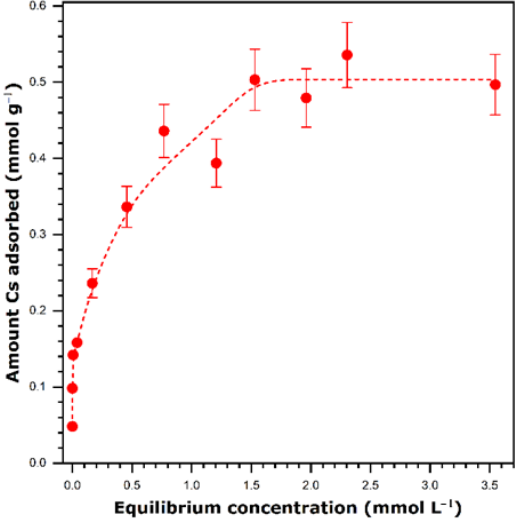
Figure 7. Sorption isotherm for cesium cations onto the hybrid hexadecylamine-vanadium oxide, VO x -C16, sample from single-component solutions in ultrapure water at 298 K. The error bars represent, for selected points, the maximum percentage error in the sorption experiments. The dashed line is drawn to guide the